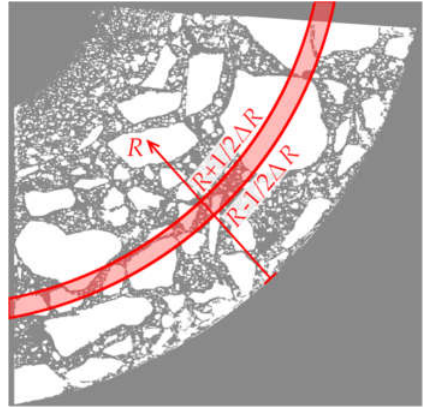
Figure 13. Way of selecting circumferential band.